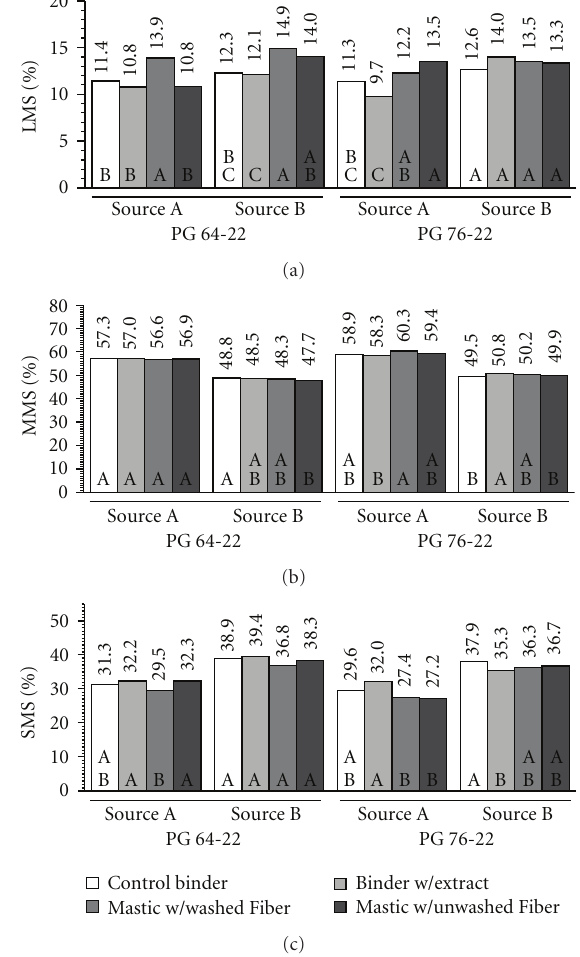
Figure 7: GPC results showing (a) LMS, (b) MMS, and (c) SMS